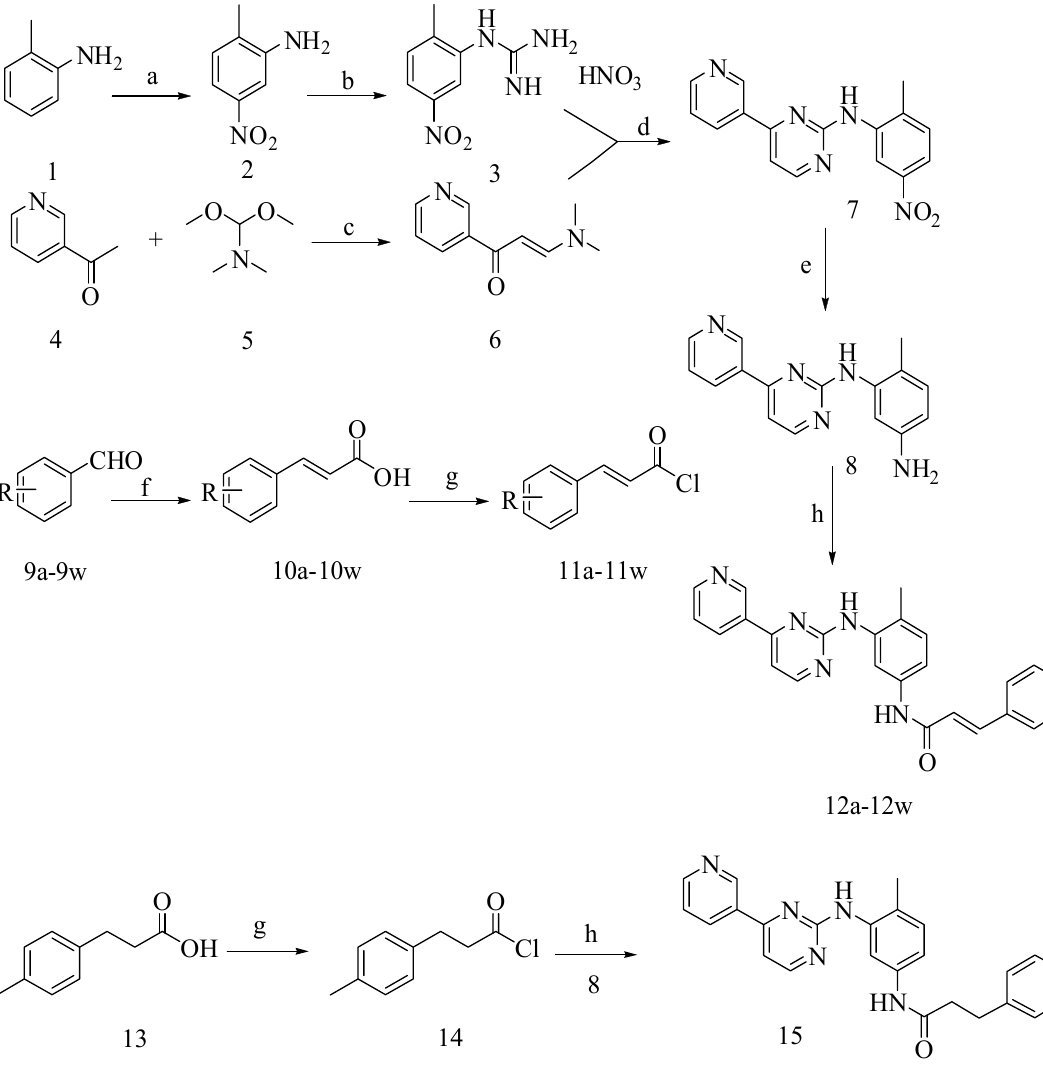
Scheme 1. Synthetic routes of the target